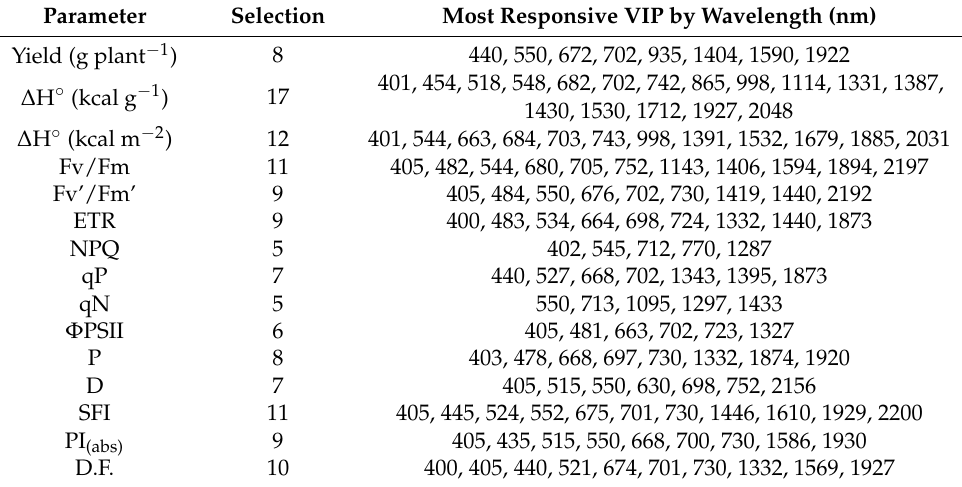
Table 4. The most responsive variable importance for projection (VIP) by wavelengths selected according to the regression coefficient for quality parameter for the PLSR model prediction. Parameter abbreviations—see Table